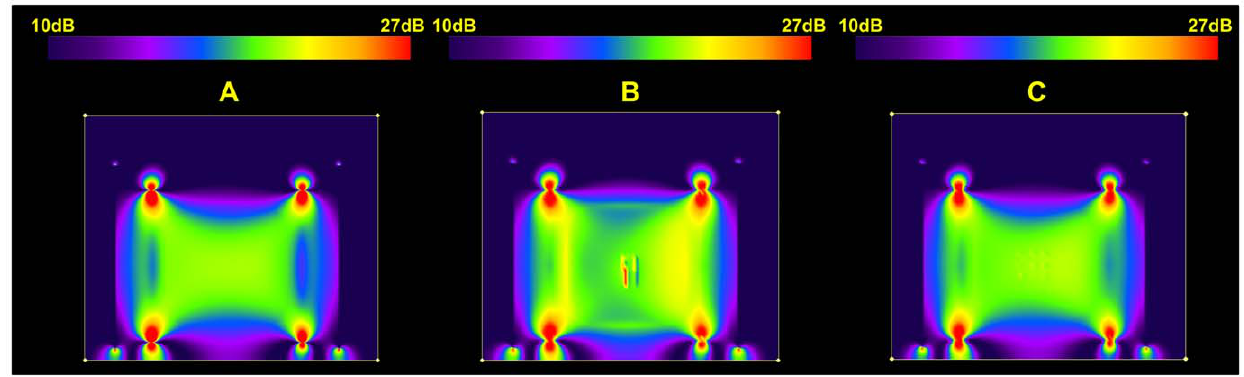
Figure 4. Results of the electromagnetic simulations. The B 1 field distribution in a plane inside the head coil and phantom containing: ( A ) no electrodes, ( B ) platinum and ( C ) PTFOS electrodes. The 0dB (red) scale corresponds to a reference value of 3.8 10 2 7